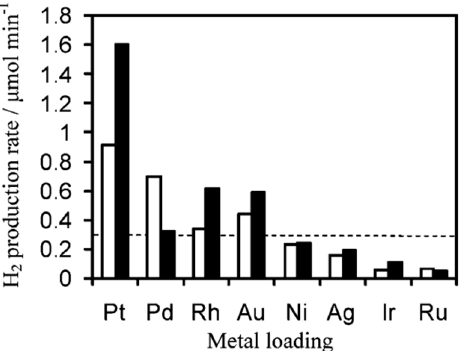
Figure 4. H 2 production rate for metal-loaded La-doped NaTaO 3 under light irradiation. The loaded amount is 0.01%. The black bars represent the data of materials calcinated at 773 K in air and the white bars show the data of samples further reduced at 673 K under H 2 . The dotted line represents the H 2 production rate of La-loaded NaTaO 3 without any co-catalyst. Reprinted with permission from [23]. Copyright (2010), American Chemical Society.